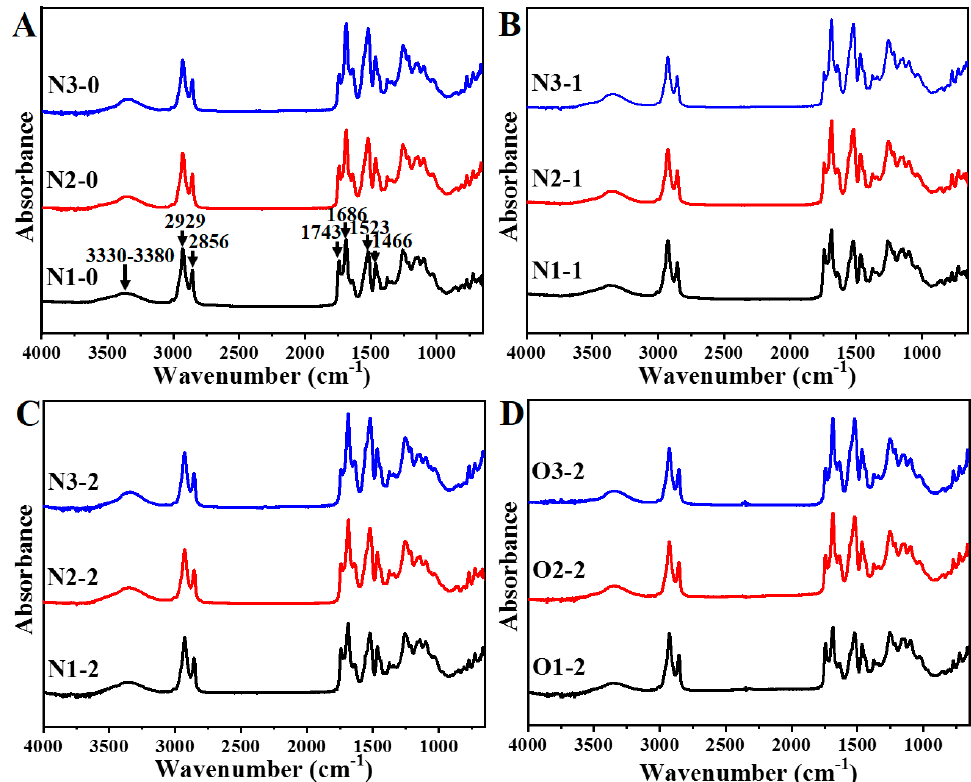
Figure 5. FT − IR spectra of 0% NOG ( A ), 10% NOG ( B ), 20% NOG ( C ) and 20% neem oil ( D ). Table 3. Relative intensity of bonded urethane, bonded urea, amide II and amide III to free urethane. allel directions. The results indicated that compressive strengths at 10% and 25% strain